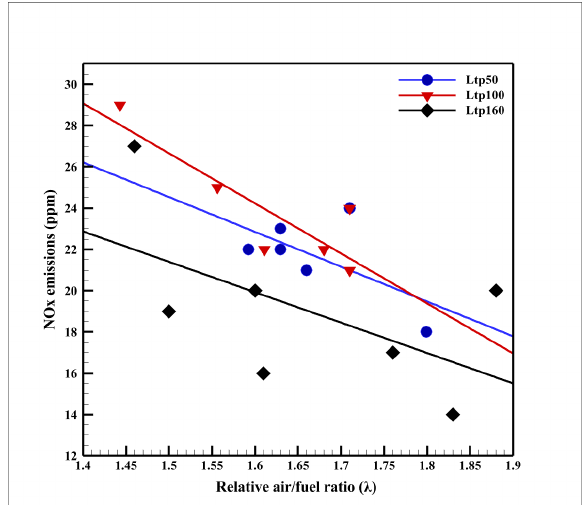
Fig. 10. Variation of NO x concentration with equivalence ratio for three tailpipe lengths (L tp )